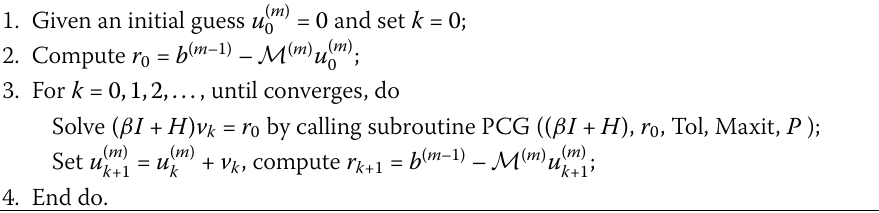
Algorithm 1 SHSS-PCG for M ( m ) u ( m ) = b ( m –1) with circulant preconditioner